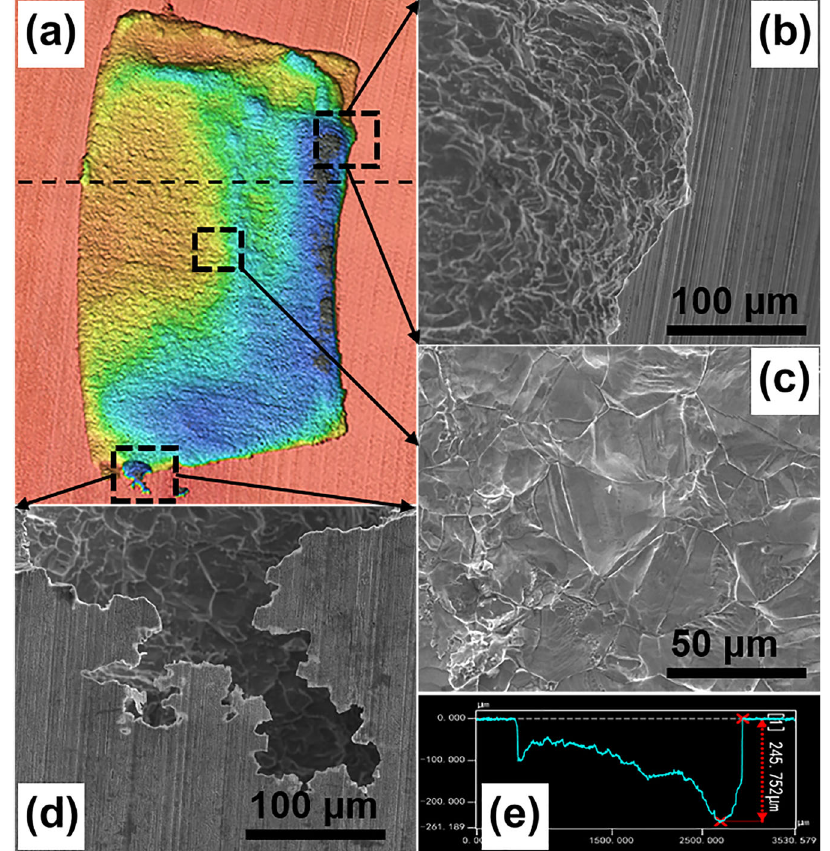
Fig. 5 Arti fi cial crevice corrosion morphologies of the 316L SS after immersing for 36 months. a 3D pro fi le of the whole crevice area, b – d local magni fi cation of different corrosion zones, e topographic pro fi le of